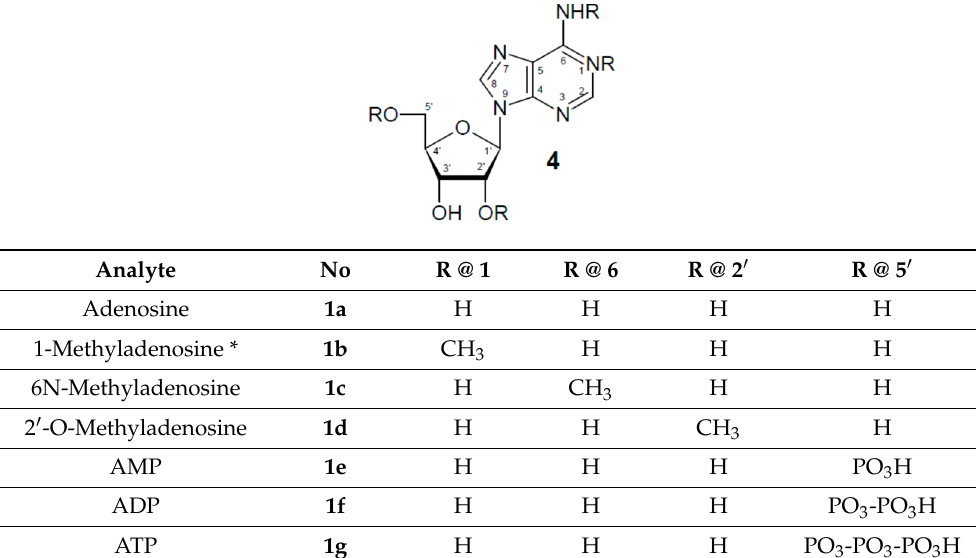
Table 1. Adenosines used in the study.